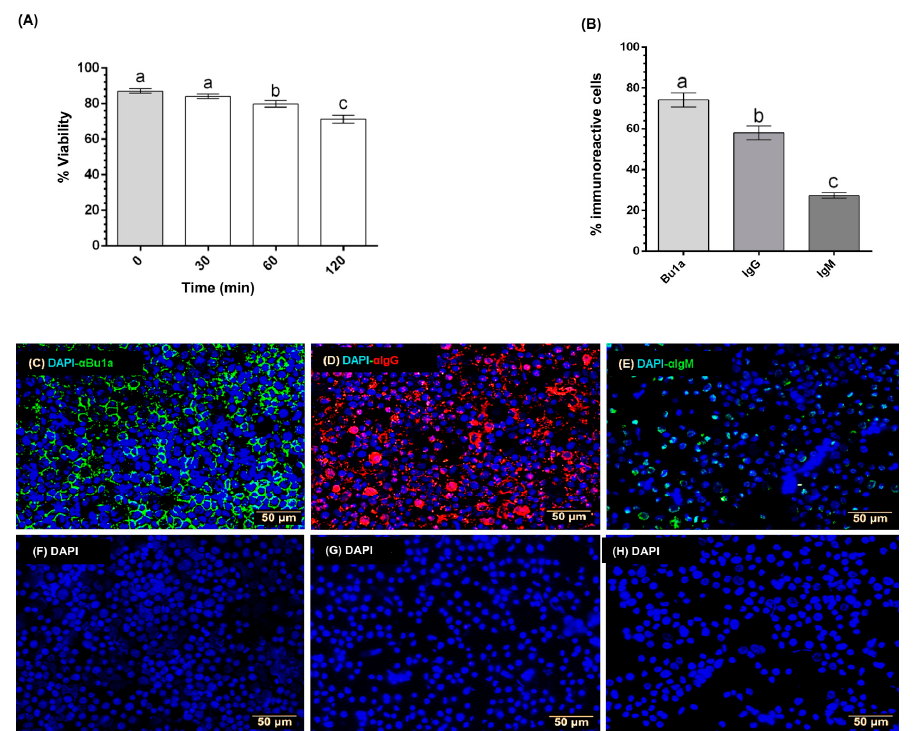
Figure 1. Characterization of bursal B-lymphocyte (BBL) cultures. Cell viability of BBLs was determined by the trypan blue exclusion method over 120 min. ( A ). Each bar represents mean ± SEM, n = 3. Groups with di ff erent letters are significantly di ff erent ( p < 0.0001) by using one-way ANOVA and Dunnett´s post-hoc test. Cell subpopulations were characterized by ICC using primary antibodies to detect whole B cells ( α -Bu1a) ( C ), mature B cells ( α -IgG) ( D ), and immature B-cells ( α -IgM) ( E ). DAPI staining was used to detect cell nuclei. Negative controls were prepared in the absence of primary antibodies ( F – H ). The proportion of BBLs subpopulations was calculated dividing the number of immunoreactive cells to each antibody between total number of DAPI reactive cells ( B ). Each bar represents mean ± SEM, n = 3. Groups with di ff erent letters are significantly di ff erent ( p < 0.001) by using one-way ANOVA and Dunnett´s post-hoc